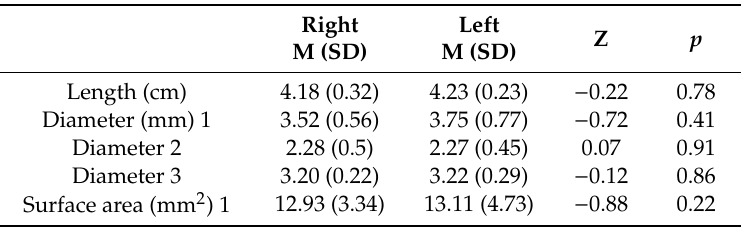
Table 2. Mean dimension values of the left and the right optic nerves measured at three di ff erent points for the LHON ( n = 15)